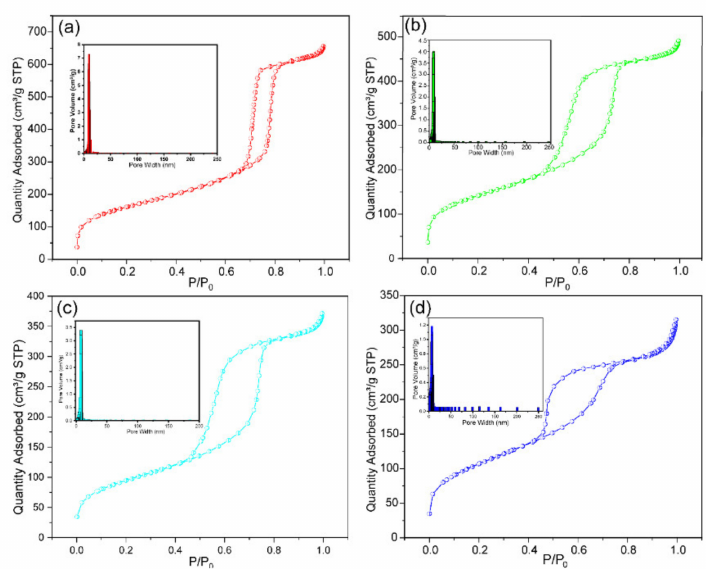
Figure 4. The nitrogen adsorption-desorption isotherm and the pore volume distribution of the